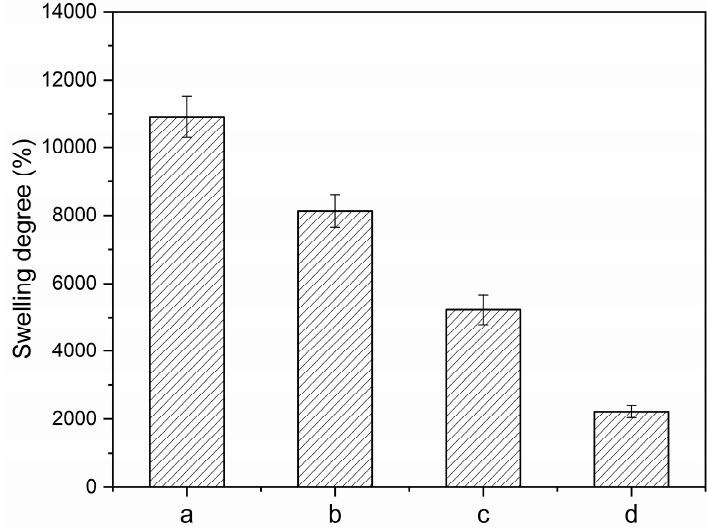
Figure 7. Swelling degree of ( a ) M0.50/P30-DPNR, ( b ) M0.50/P30-DPNR/Si10, ( c ) M0.50/P30- DPNR/Si20 and ( d ) M0.50/P30-DPNR/Si30 after immersion in DI water for 24 h.